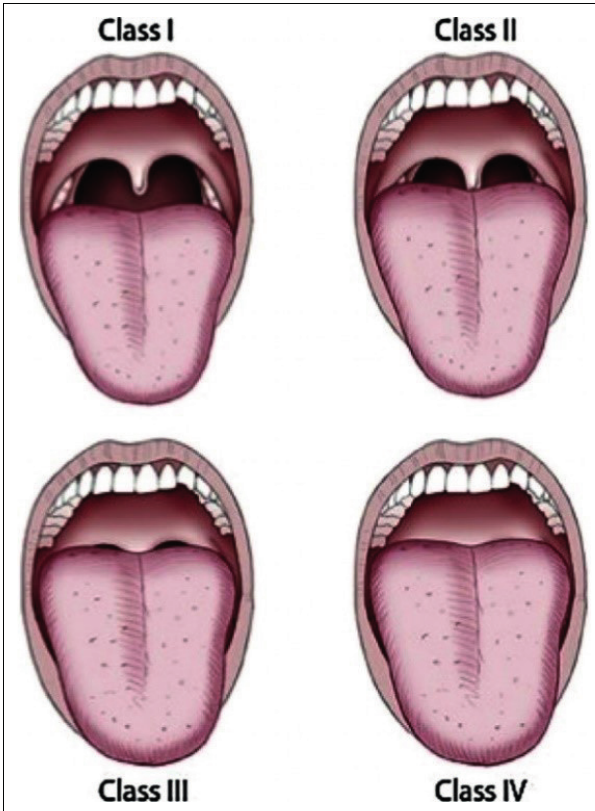
FIGURE 1: Mallampati classification: Class I: fully visible uvula and soft palate; Class II: hard and soft palate and upper portion of uvula are visible; Class III: soft and hard palate and base of uvula are visible; Class IV: only hard palate